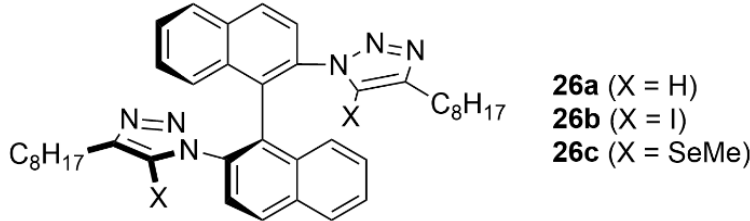
Figure 15. Structure of chiral hosts 26a – c .